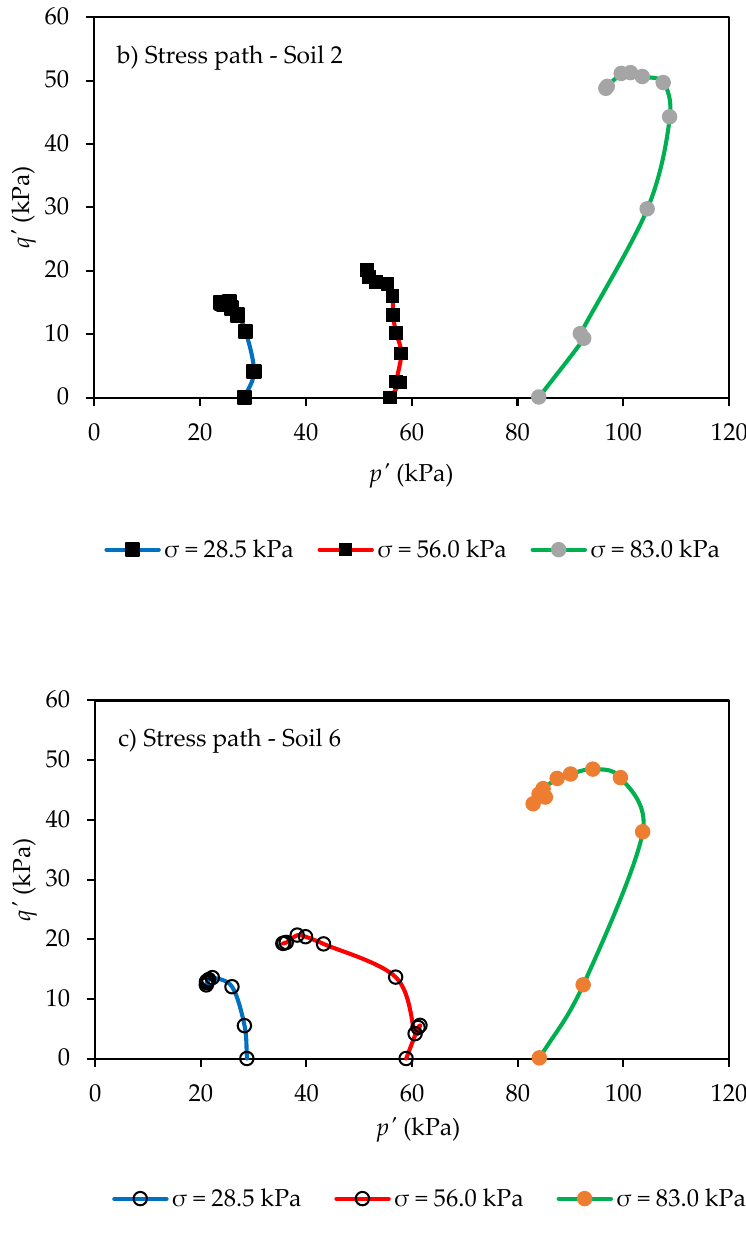
Figure 1. Stress-path plot of Soil 1 ( a ), Soil 2 ( b ) and Soil 6 ( c